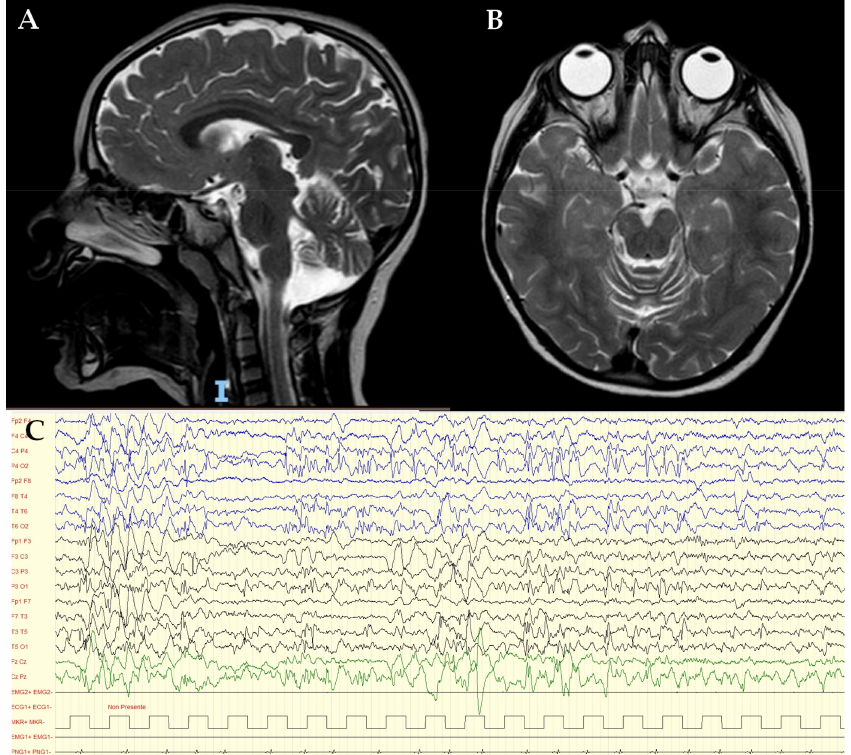
Figure 1. Sagittal ( A ) and axial ( B ) brain and spinal cord MRI showed diffuse and bilateral cerebellar atrophy and bilateral and symmetrical hyperintensity of the posterior periventricular white matter and mesial portions of the thalami, on T2 and FLAIR sequences; ( C ) EEG show focal epileptiform anomalies in the middle-posterior regions and diffuse